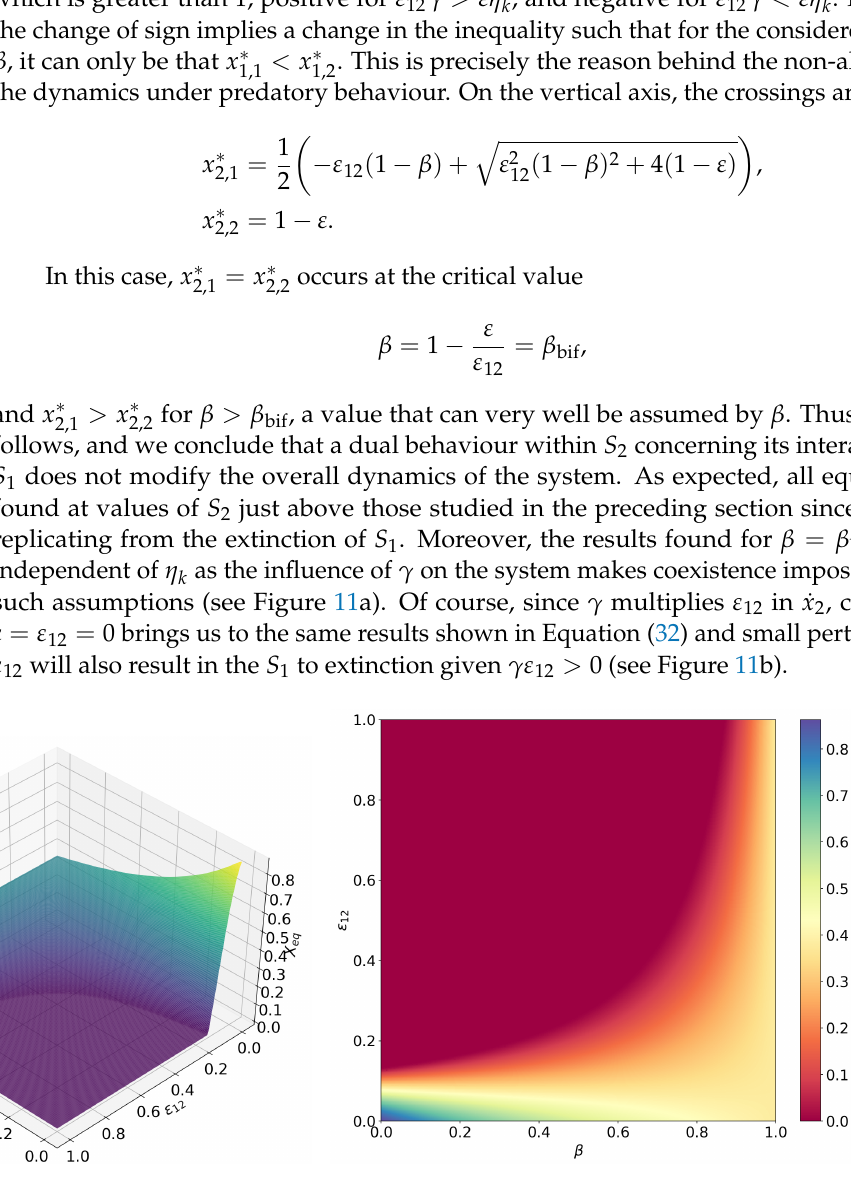
Figure 10. Two-parameter bifurcation diagram representing x ∗ map ( b ) for a more intuitive understanding. Parameters used: ε = 0.13, η k = 1.4, γ =